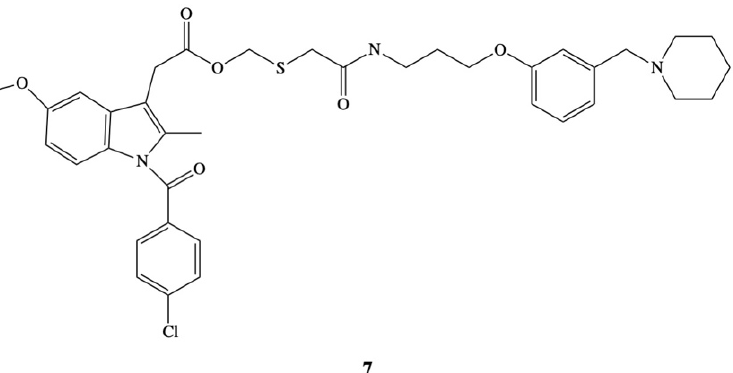
Figure 5. Chemical structure of 2-[ N -[3-{3-(Piperidinomethyl)phenoxy}propyl]carbamoylmethylthiol]-ethyl 1-( p -chlorobenzoyl)-5-methoxy-2-methylindole-3-acetate (7) .